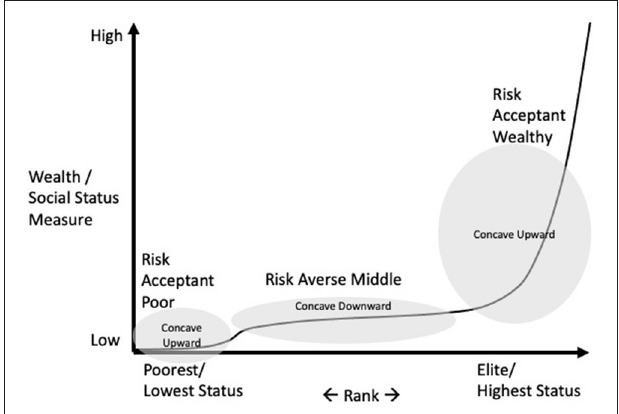
FIGURE 1 | Wealth distribution, class, and risk